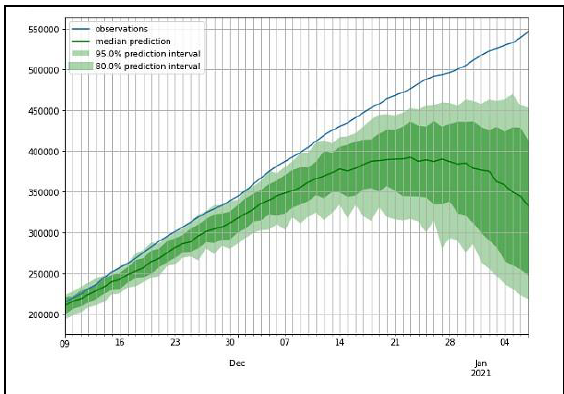
Fig.10. DeepAR with GRU cells “training data”